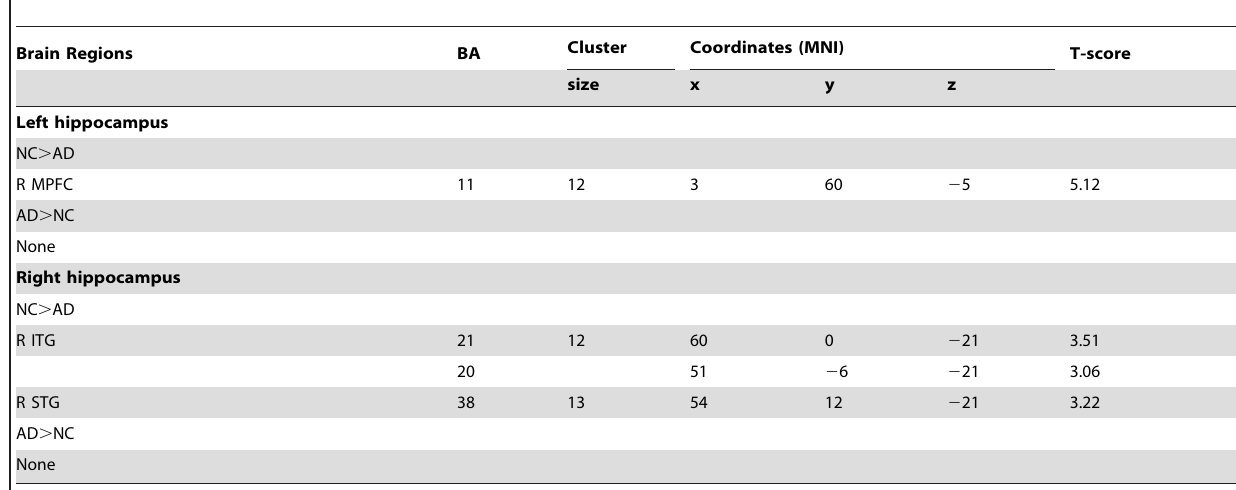
Table 2. Regions showing decreased and increased hippocampal connectivity in AD subjects during resting state.